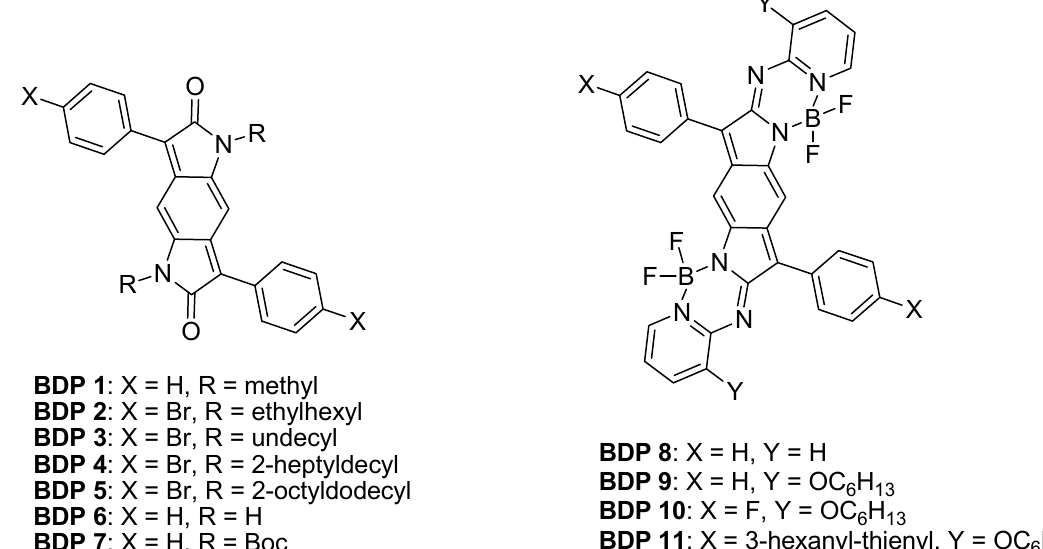
Figure 4. Structures of small molecular based on phenyl-flanked BDP ( left ) and BDP-based aza-BODIPY ( right ) derivate.